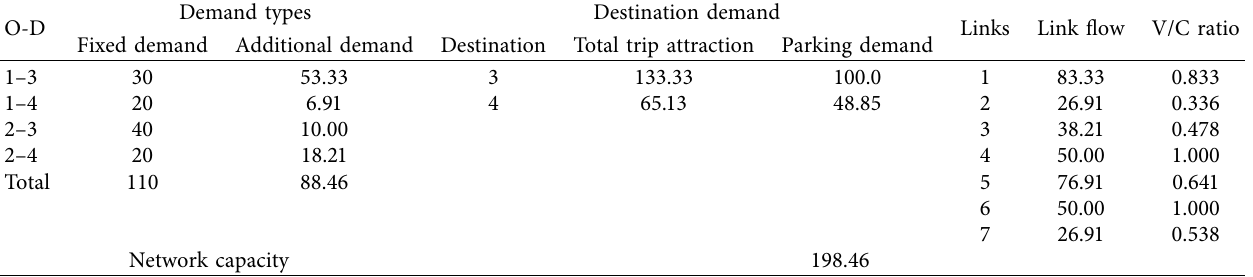
Table 5: Results of the proposed road network capacity model.